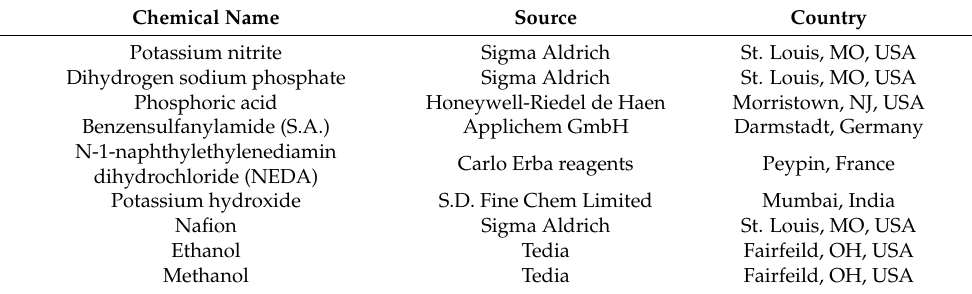
Table 2. The chemicals used in the nitrite detection in this